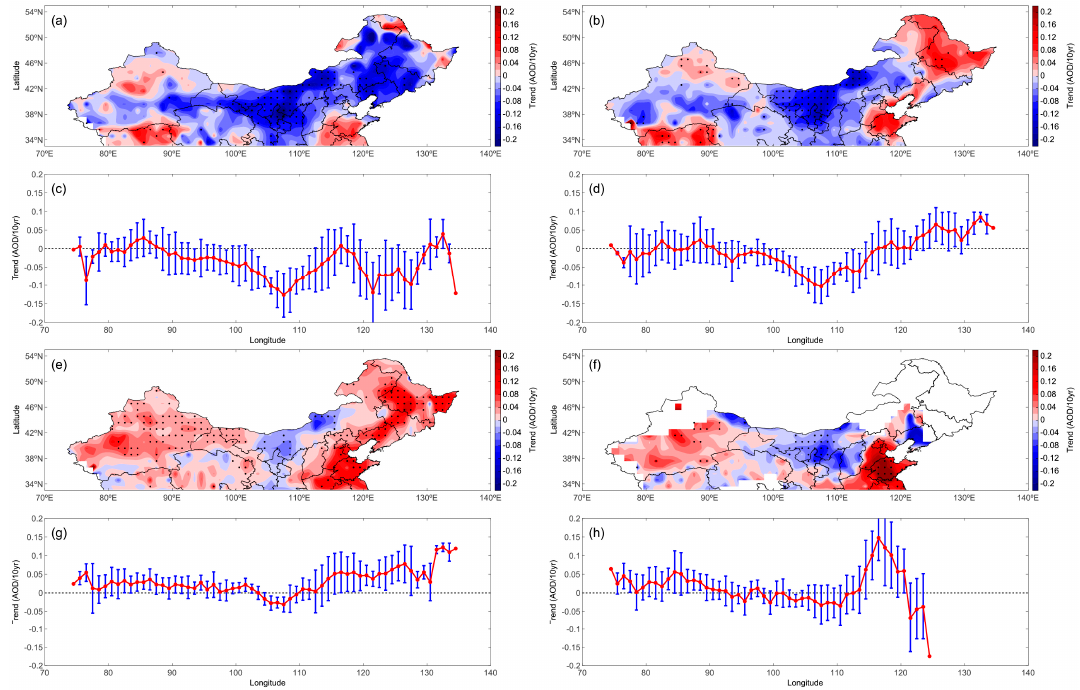
Figure 8. Seasonal spatial distributions of linear trends from MODIS AOD over North China and the corresponding meridionally averaged trends in ( a , c ) spring, ( b , d ) summer, ( e , g ) autumn, and ( f , h ) winter, for the period 2001–2016. Dots indicate significance at 95% confidence level.